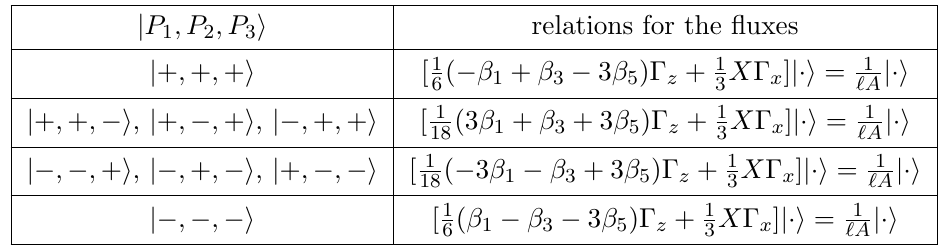
Table 6 . Decomposition of (4.55) KSE into